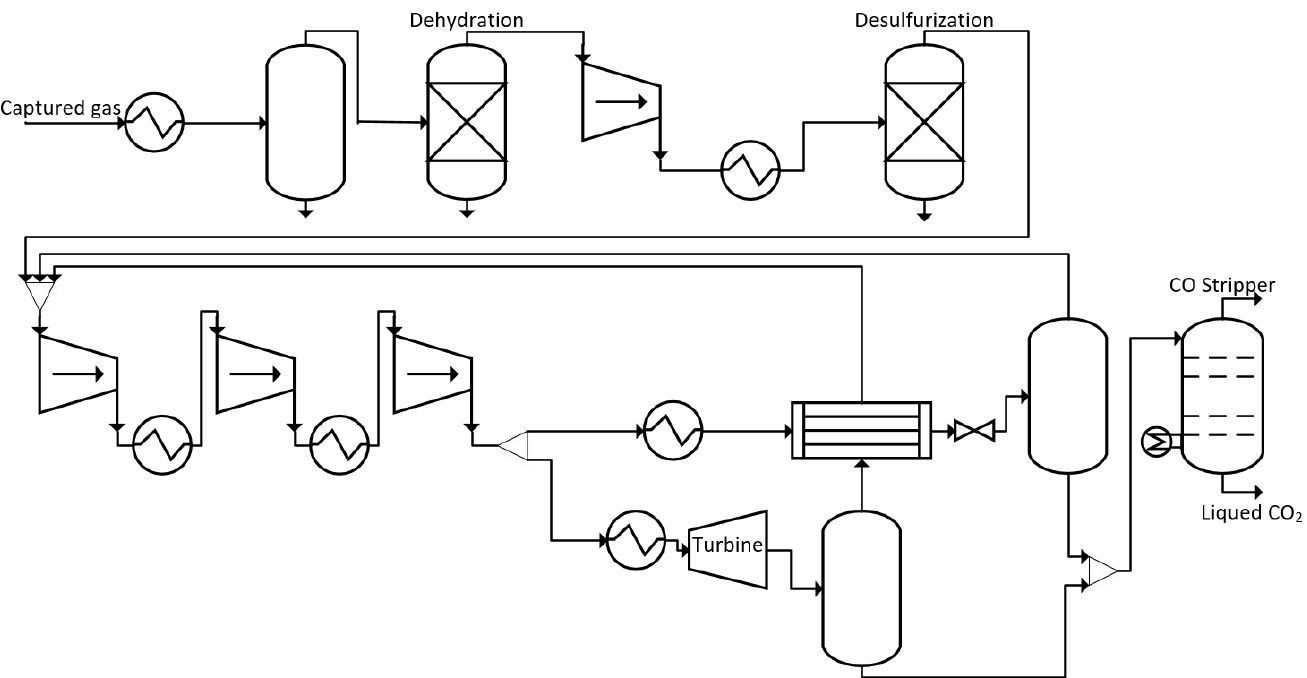
Figure 6. Process flow diagram for the open-cycle liquefaction design with a turbine.